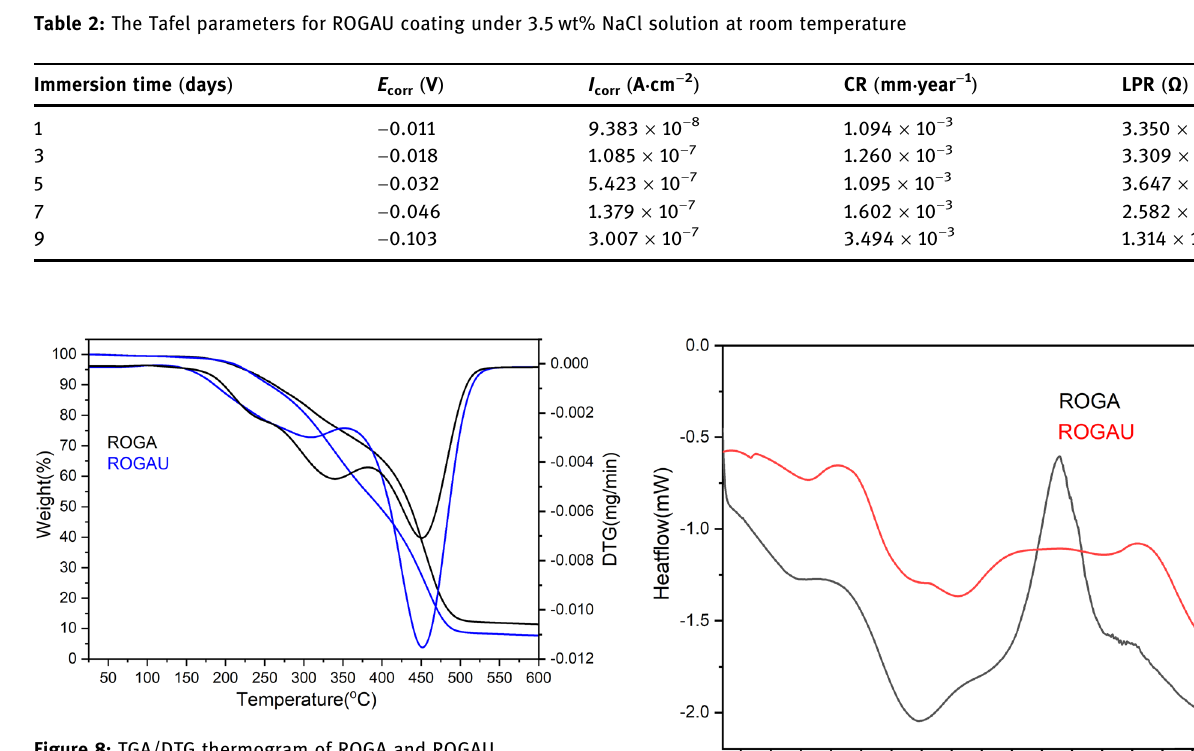
Figure 8: TGA/DTG thermogram of ROGA and ROGAU.